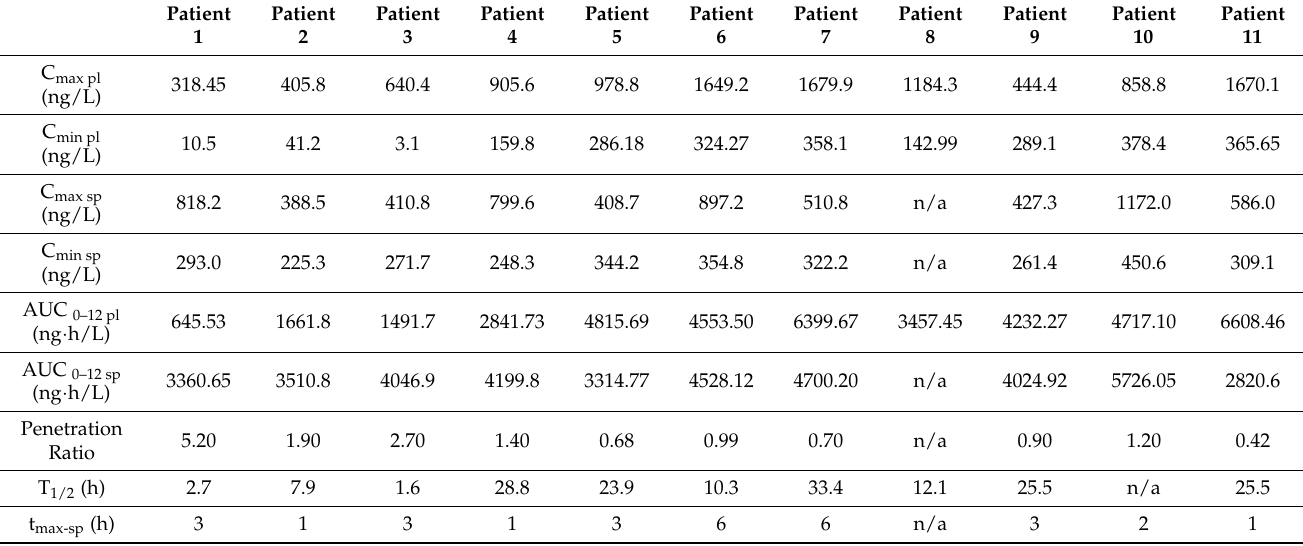
Table 2. Tigecycline main pharmacokinetic parameters estimated after the administration of the 7th dose of the standard regimen to 11 patients hospitalized due to an acute COPD exacerbation.